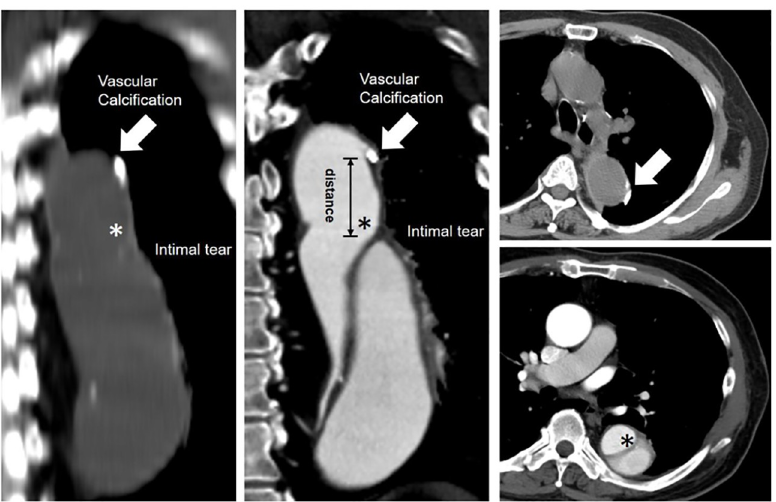
Fig 1. Representative figure of the determination of variables associated with aortic calcification (arrows) and intimal tears (asterisks).